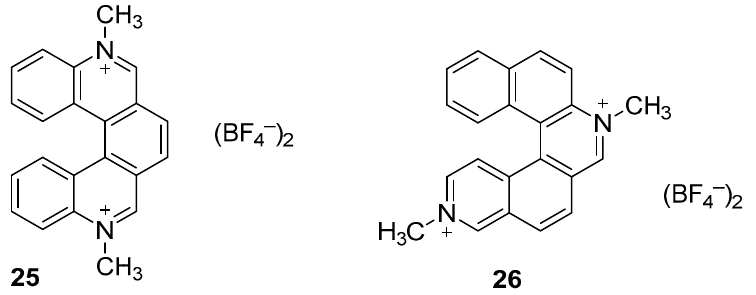
Figure 5. Two viologen-like dications.